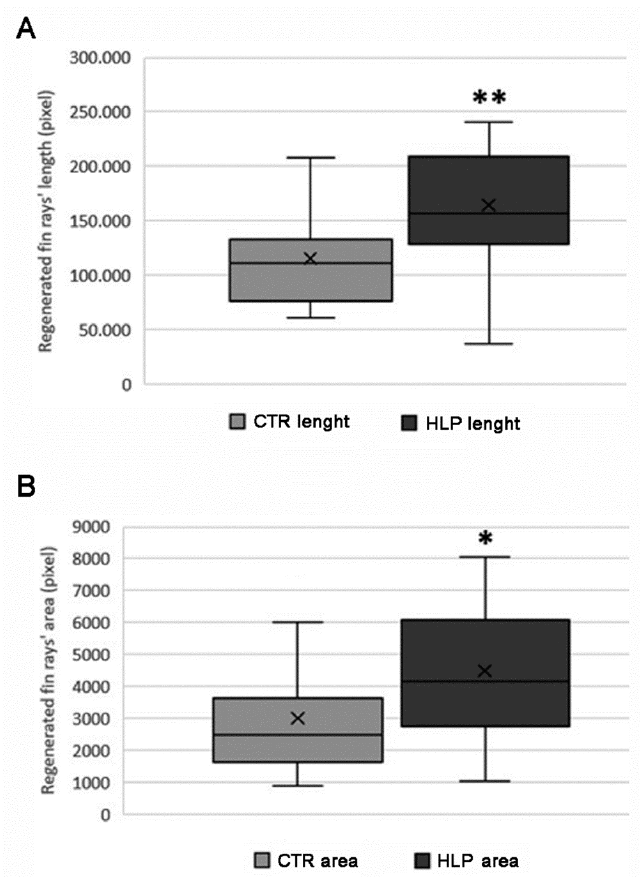
Figure 5. Measurements in untreated (CTR, seven fish) and treated with HI LF-PEMFs (HLP, seven fish) adult zebrafish of ( A ) regenerated fin rays’ length (HLP vs. CTR, ** p < 0.01) and ( B ) regenerated fin rays’ area (HLP vs. CTR, * p < 0.05).